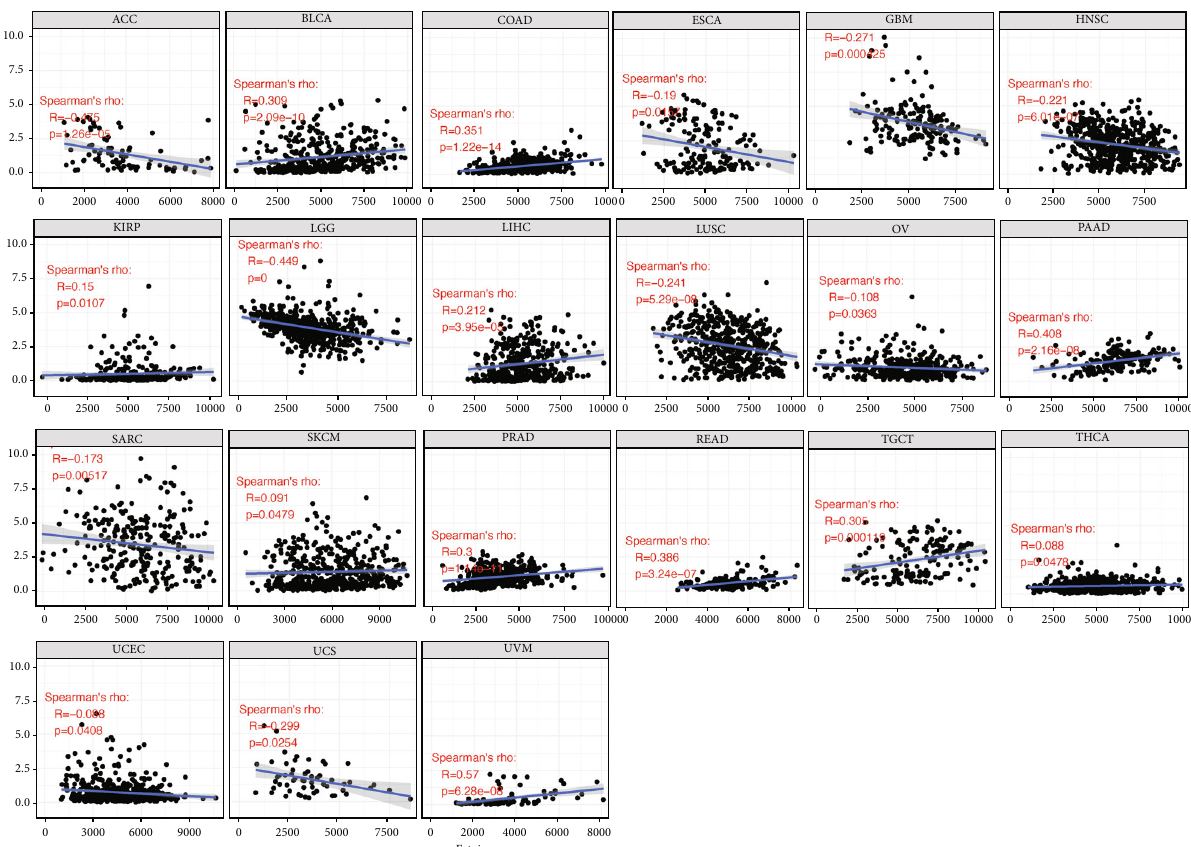
Figure 6: Correlation of B4GALNT1 expression with ImmuneScore in ACC, BLCA, COAD, ESCA, GBM, HNSC, KIRP, LGG, LIHC, LUSC, OV, PAAD, SARC, SKCM, PRAD, READ, TGCT, THCA, UCEC, UCS, and